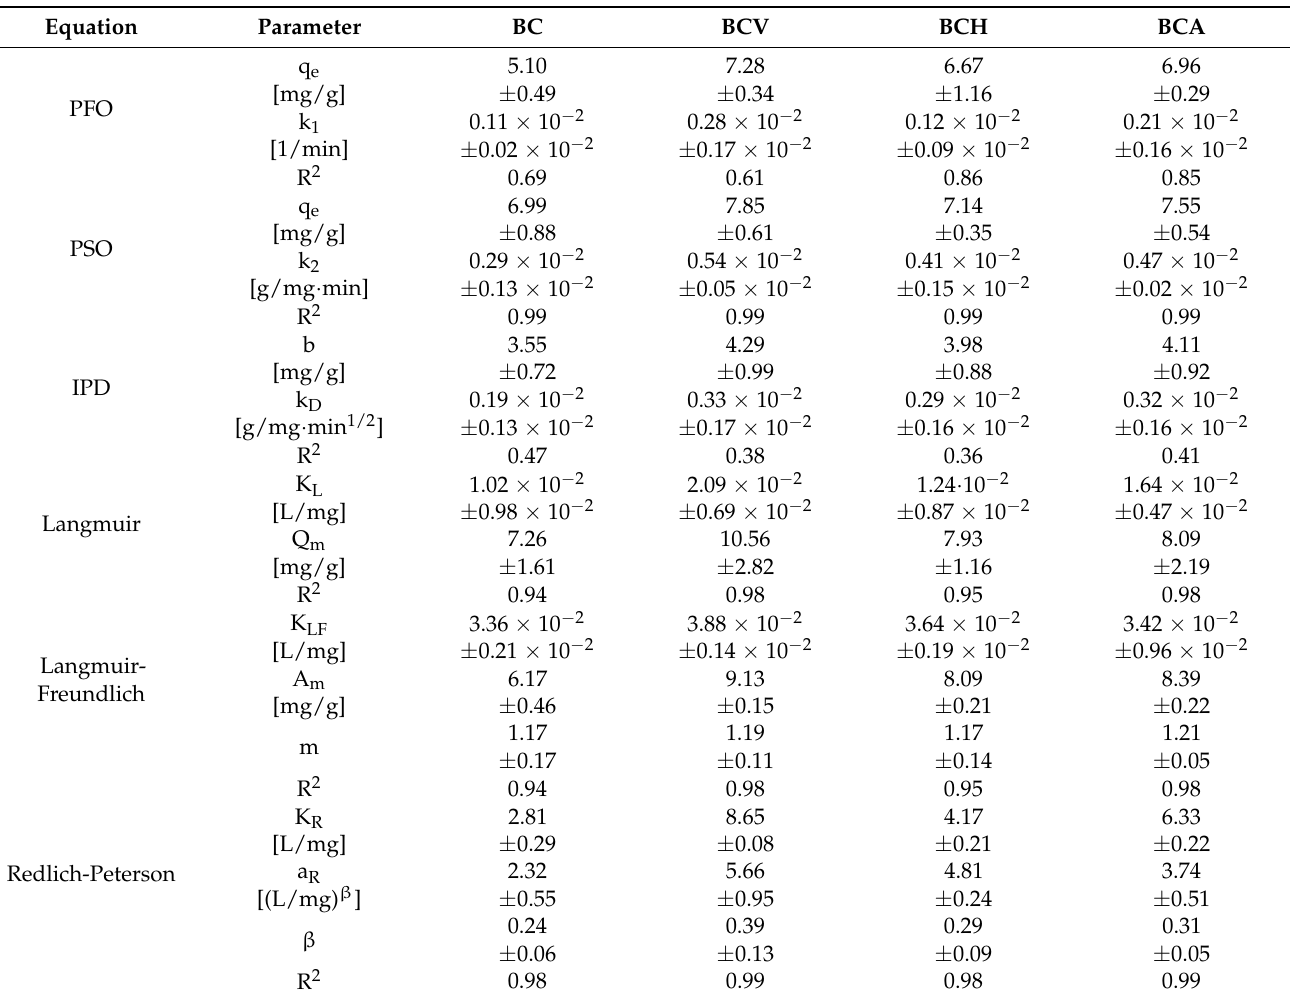
Table 5. Kinetic and isotherms parameters for TC adsorption on modified and non-modified